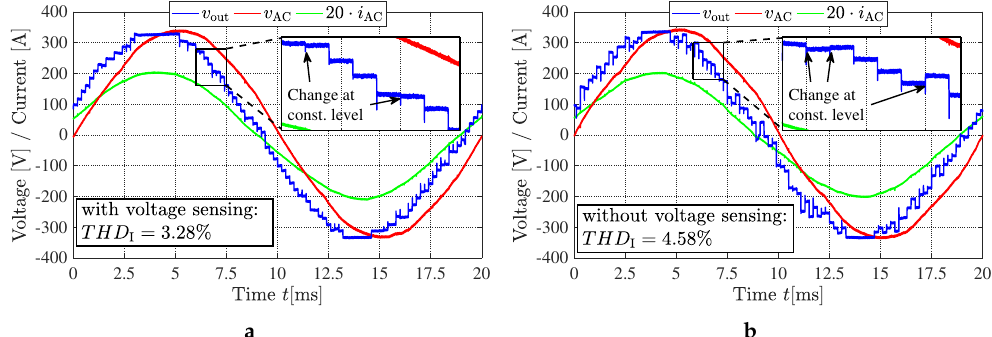
Figure 9. Measured operation of 33-level asymmetric MLC, controlling a grid current of ˆ I AC = 10A, ( a ) with and ( b ) without sensing of the capacitor voltages.